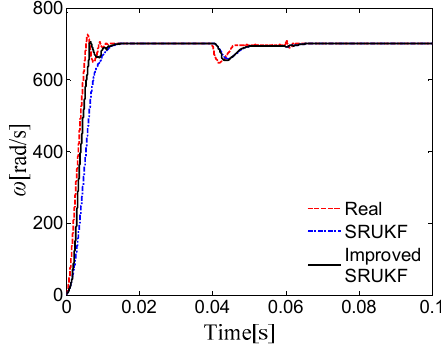
Figure 11. Speed estimation at load disturbance.